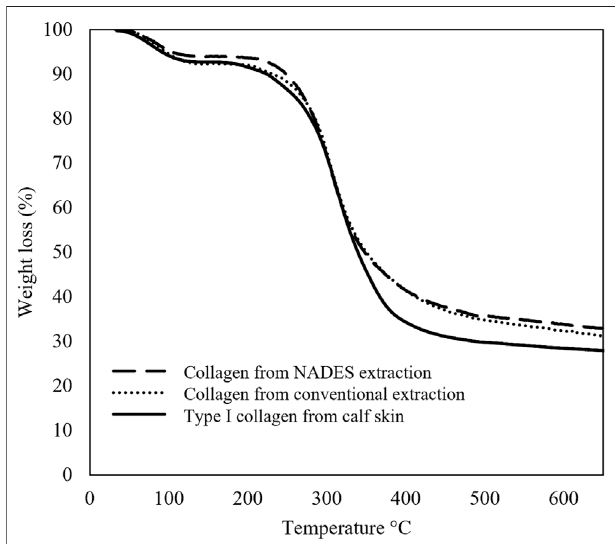
FIGURE 3 | TGA data of the collagen extracts obtained from blue shark skins with conventional solvent and NADES and collagen standard from calf